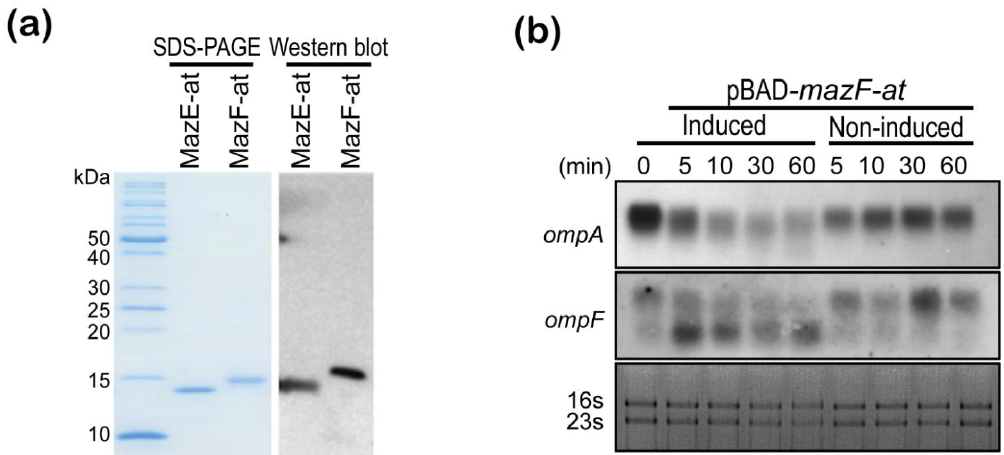
Figure 4. ( a ) Protein purification and Western blot assay using anti-his 6 antibody of MazE-at and MazF-at. 1.5 ng of purified MazE-at and MazF-at proteins with N-terminal His 6 -tag were separated by 15% SDS-PAGE gel, and the gel was stained with Coomassie blue (left panel). Western blot analysis was performed on PVDF, and the blots were detected by anti-his 6 antibody (right panel); ( b ) Effect of MazF-at on cellular mRNA stability using Northern blot assay. The total RNAs were extracted from E. coli BW25113 cells harboring pBAD24- mazF-at with (induced) or without 0.2% L-arabinose (non-induced) at 0, 5, 10, 30, and 60 min after the induction, and Northern blotting was performed using the ompF or ompA mRNA specific probes labeled with biotin-14-dCT.